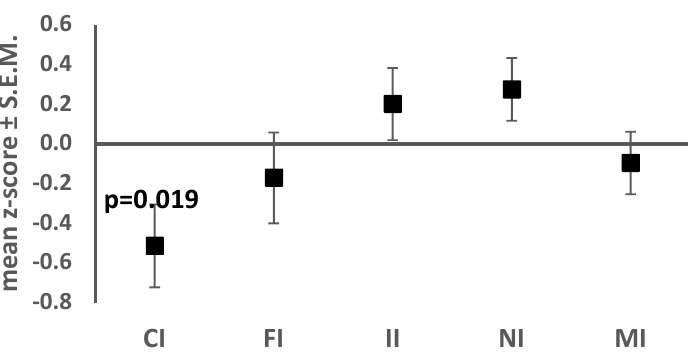
Figure 2. Anthropometric z -scores in the sample of 33 ASD patients (CI: Cephalic index, FI: Facial